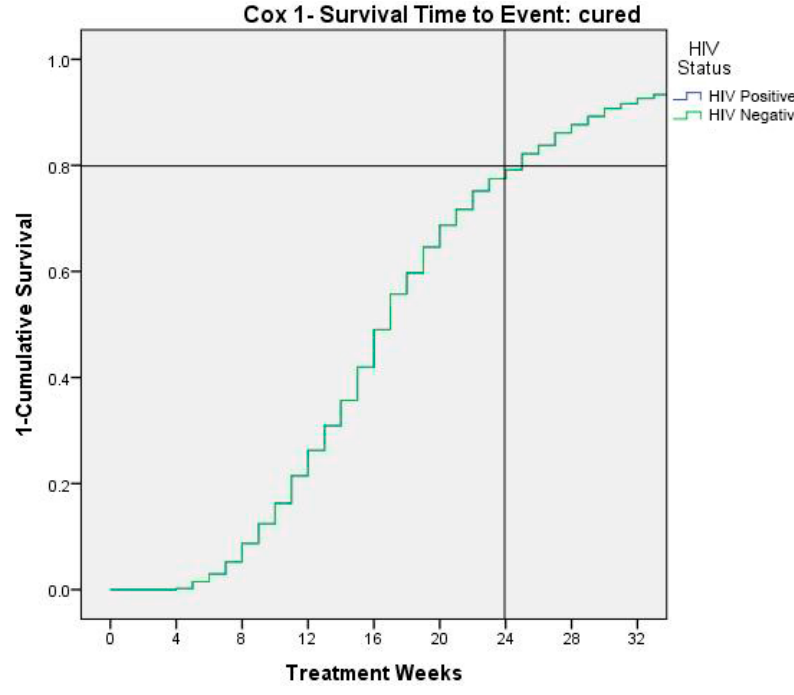
Figure 4. Time to cure events as 1- survival.